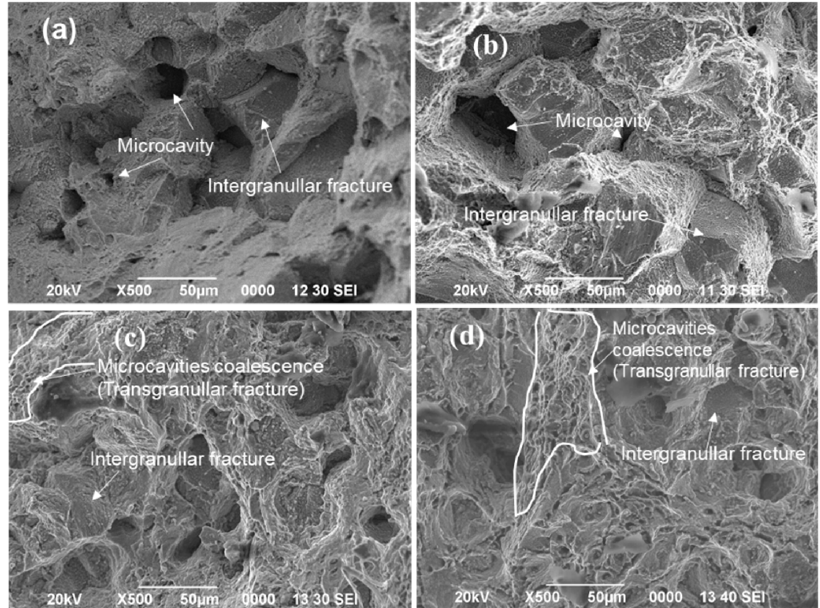
Figure 19. SEM observations of the fracture surface of the 253 MA ASS ( a ) without annealing and with annealing times of ( b ) 900; ( c ) 1800; ( d ) 3600 s after creep rupture test with a 500 × magnification.